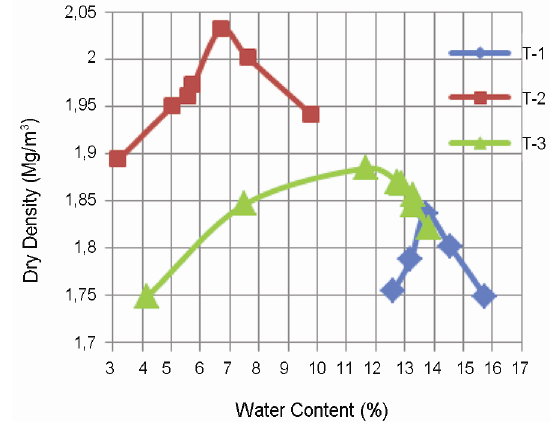
Fig. 5. Moisture- density relationship for three subbase mate- rials